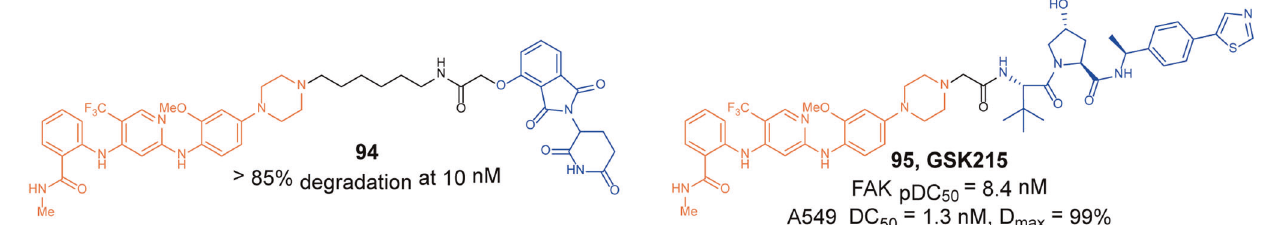
Fig. 22 The representative PROTACs targeting FAK